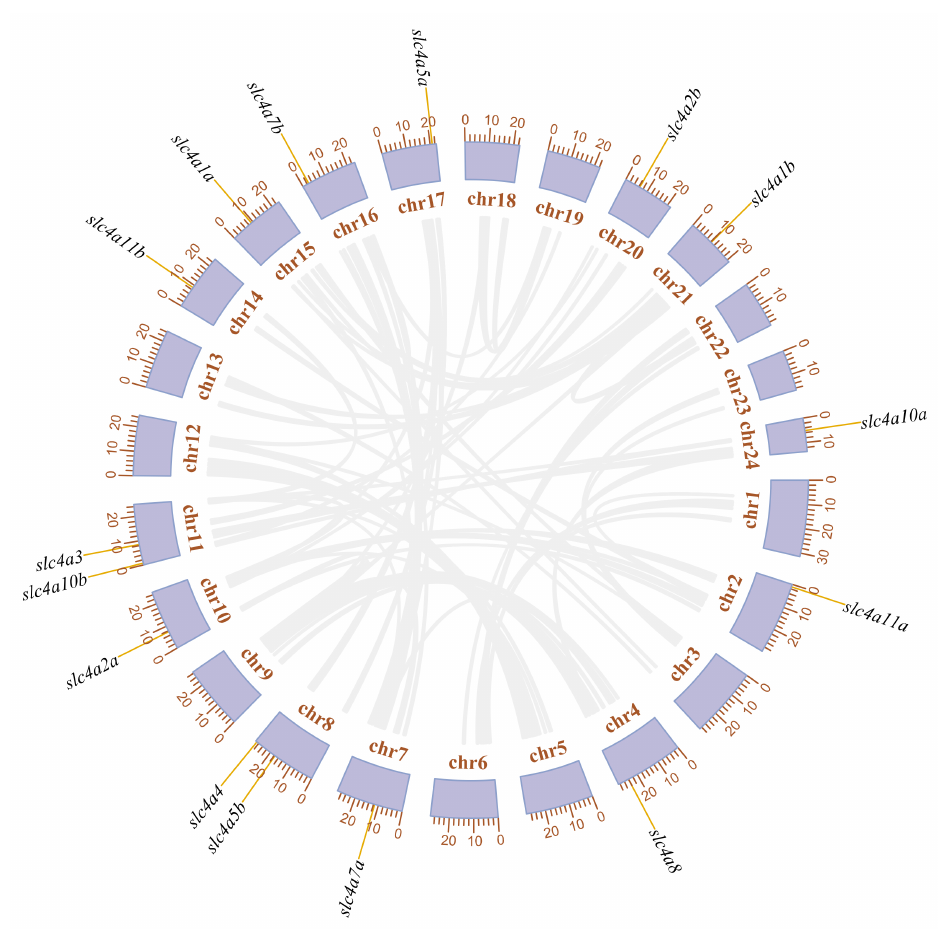
Figure 3. Chromosomal locations and duplication modes among the slc4 genes of spotted sea bass. Genomic synteny is displayed in gray lines.